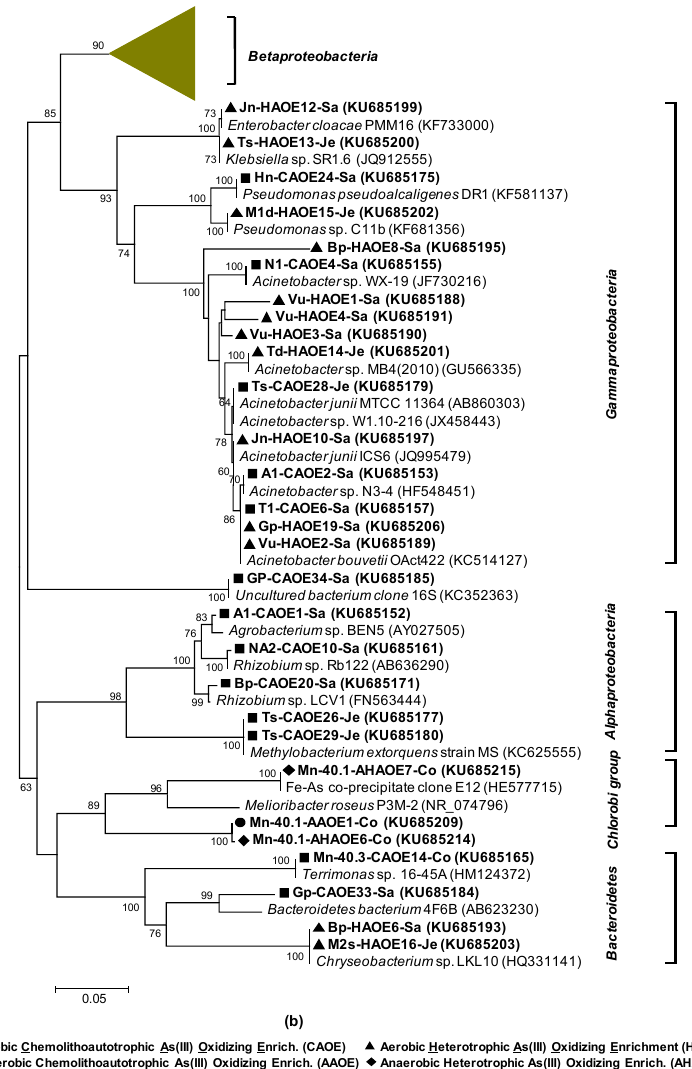
Figure 2. Phylogenetic analysis of 16S rRNA gene sequences (550 unambiguously aligned nucleic acid positions) determined for the excised DGGE bands shown in Figures 1a, 1b and 1c. The phylogenetic tree is shown in two parts. The major branch of Betaproteobacteria -related sequences was expanded in Figure 2a, where the four major branches related to other bacterial sequences (i.e., Alpha -, Gamma-proteobacteria , Chlorobi group and Bacteroidetes ) were compressed in horizontal triangles at the bottom. The latter triangles were expanded in Figure 2b and the Betaproteobacteria class compressed to the triangle at the top. Sequences in bold, normal type are indicated by enrichment ID, enrichment condition (CAO, HAO, AAO, and AHAO), the number of the excised band as shown in Figure 1a, Figure 1b, or Figure 1c, and the district in which the well is located (e.g., K1-CAOE13-Sa refers to village code K1 = Kaliganj, district code [Sa] = Satkhira, CAOE refers to type of enrichment = aerobic chemolithoautotrophic arsenite-oxidizing enrichment, 13 refers to the number of the band excised as in Figure 1a, the lane for K1). IDs labeled AHAO: chemoorganoheterotrophic arsenite-oxidizing enrichments had acetate as the heterotrophic carbon source. The trees were constructed with the neighbor-joining method and bootstrap values (1000 replications) are indicated at the interior branches. The scale bar represents 5% sequence divergence. 16S rRNA gene sequences are accompanied by distinct closed symbols referring to the enrichment conditions used (squares: CAO; triangles: HAO; circles: AAO and inverted triangles: AHAO). Italics indicate sequences derived from already known strains as available from the GenBank data base (http: // www.ncbi.nlm.nih.gov / Genbank /